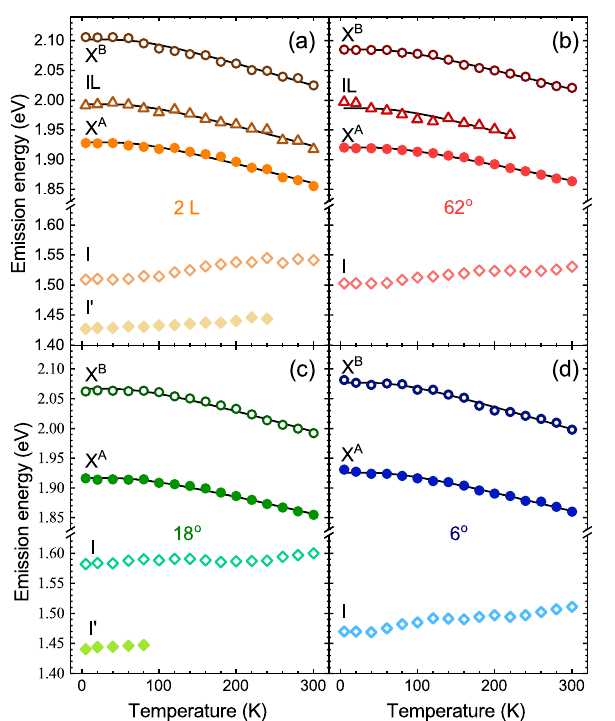
Figure 5. Temperature evolution of the energies of the transitions extracted from PL spectra measured on MoS 2 : ( a ) bilayer (2 L) and selected homobilayers with twist angles of ( b ) 62 ◦ , ( c ) 18 ◦ and ( d ) 6 ◦ . The solid black curves are fits to the data obtained with the aid of Odonnell’s